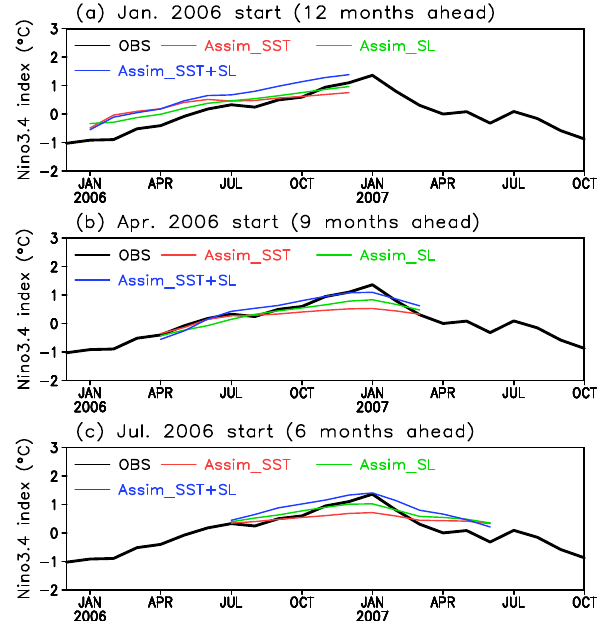
Figure 5. Comparisons of the hindcast results for the 2006–2007 El Niño event. The thick black curves are the observed Niño 3.4 SST anomalies, and the thin curves of red, green, and blue are the pre- dictions initialized by the Assim_SST + SL, Assim_SST, and As- sim_SL assimilation results, respectively. (a) , (b) , and (c) are hind- casts that started 12, 9, and 6 months, respectively, ahead of the peak of the 2006–2007 El Niño